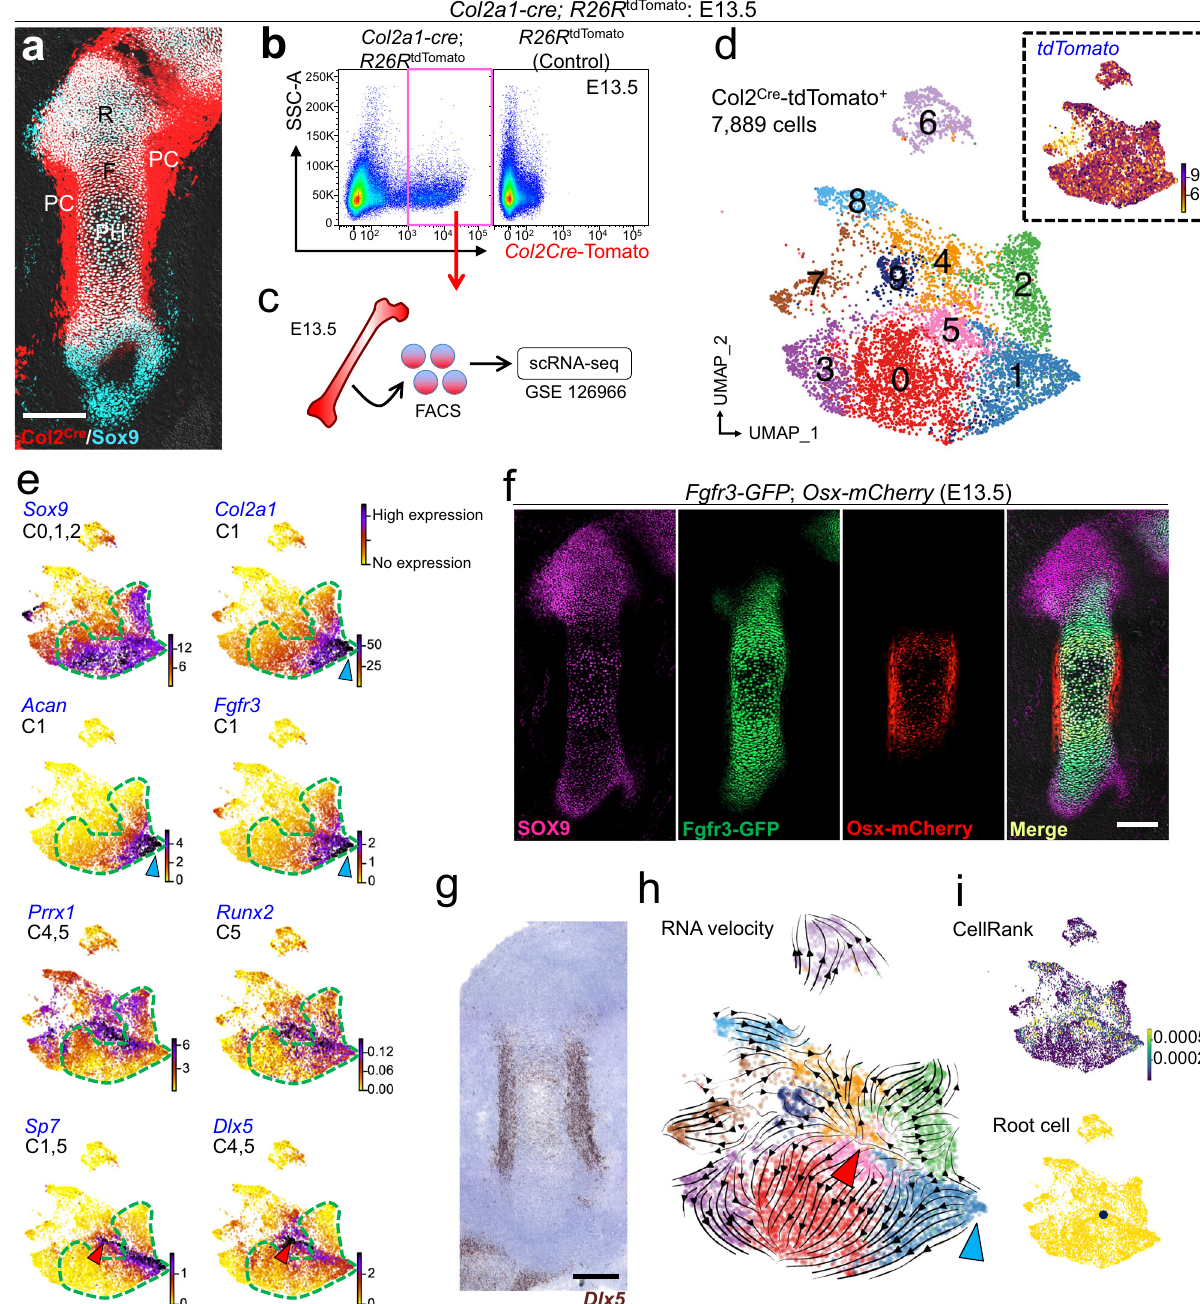
Fig. 1 | Single-cell RNA-seq identi fi es a perichondrial cluster as a putative cell origininthefetalcartilage.a – e Single-cellRNA-seqanalysisof Col2a1-cre -marked chondrocytes and perichondrial cells at E13.5. a : Col2a1-cre ; R26R tdTomato femur immunostained for SOX9. R round layer, F fl at layer, PH prehypertrophic layer, PC perichondrium, Grey DIC. Scale bar: 200 µ m. n =3 mice. b , c FACS ( b ) and scRNA- seq ( c ) strategy for Col2a1 cre -tdTomato + cells (red box). Shown are cells isolated from Col2a1-cre ; R26R tdTomato limbs(left)or R26R tdTomato controllimbs(right). d UMAP plotofmajorclassesofCol2a1 cre -tdTomato + cells(Cluster0 – 9,7,889cells).Pooled from n =5 mice. Dotted box: Feature plot of tdTomato . e Feature plots of repre- sentative genes enriched in each cluster. Cluster 0,1,2: Sox9 + (green dotted